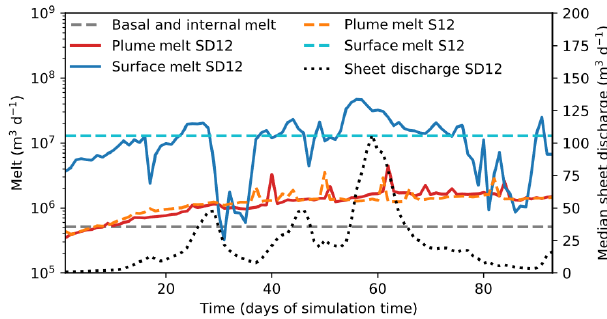
Figure 8. Time series of melt sources in SummerDaily17 (red and blue solid lines) and SummerAverage17 (orange and light blue dashed lines) model runs. Note logarithmic y axis. Basal and inter- nal melt were constant across both runs and are included for com- parative purposes – note how plume melt is of equal or greater im- portance. Median sheet discharge (dotted line; taken as the median over the whole model domain) shows the response of the subglacial hydrological system to surface melt and evolution of the system to- wards greater channelisation over the melt